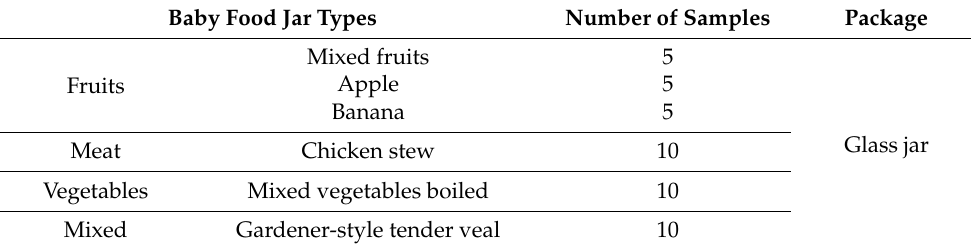
Table 2. Descriptive parameters of the analyzed